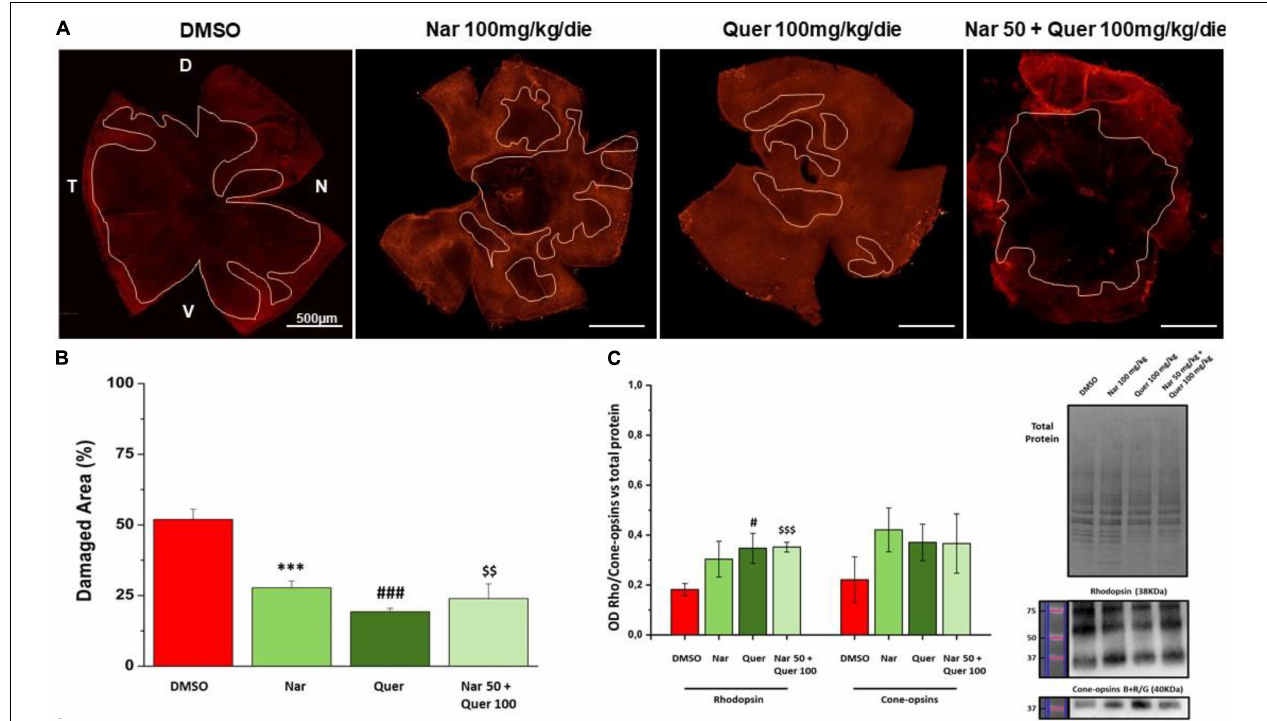
FIGURE 5 | Morphological assessment of the damaged area. (A) Morphology of whole-mount retina of naringenin 100 mg/kg/die, quercetin 100 mg/kg/die, naringenin 50 + quercetin 100 mg/kg/die treated groups and pathological control (cone-arrestin, red). The pink line delineates the damaged area after photo-induction. (B) Histogram for quantification of the damaged area as a percentage of total retinal area for each treatment and control. Each treatment group used to study retinal morphology consisted of n = 6 animals. The bars represent mean ± SEM; the statistical analysis was performed using one-way ANOVA test followed by Bonferroni test ( ∗∗∗ p ≤ 0.001, naringenin 100 group vs. DMSO group; ### p ≤ 0.001, quercetin 100 group vs. DMSO group; $$ p ≤ 0.01, naringenin 50 + quercetin 100 group vs. DMSO group). (C) WB analysis for the treatment and control groups. On the right, the image of the bads related to total protein, RHO, and cone–opsins blue + red/green; on the left, the histogram related to the quantification, by optical densitometry, of RHO and cone–opsins. The number of animals used for WB analysis was, respectively, DMSO ( n = 6); naringenin 100 mg/kg/die ( n = 11); quercetin100 mg/kg/die ( n = 6); naringenin 50 + quercetin 10 mg/kg/die ( n = 6). The data are representative of animals ± SEM. The bars represent each value normalized with the total protein and then compared with the control group (DMSO only); the statistical analysis was performed using one-way ANOVA test followed by Bonferroni test ( # p ≤ 0.05, quercetin 100 group vs. DMSO group; $$$ p ≤ 0.001, naringenin 50 + quercetin 100 group vs. DMSO